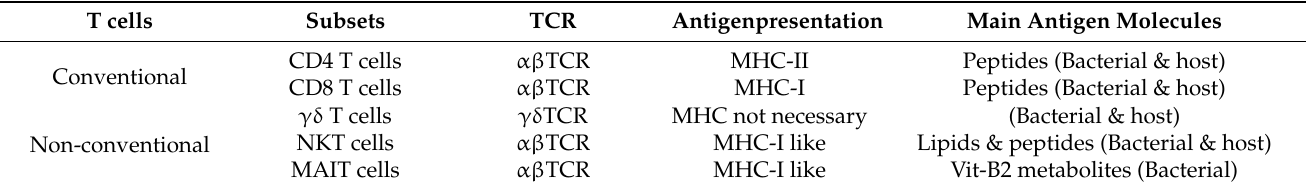
Table 1. Summary of antigen processing in T cell